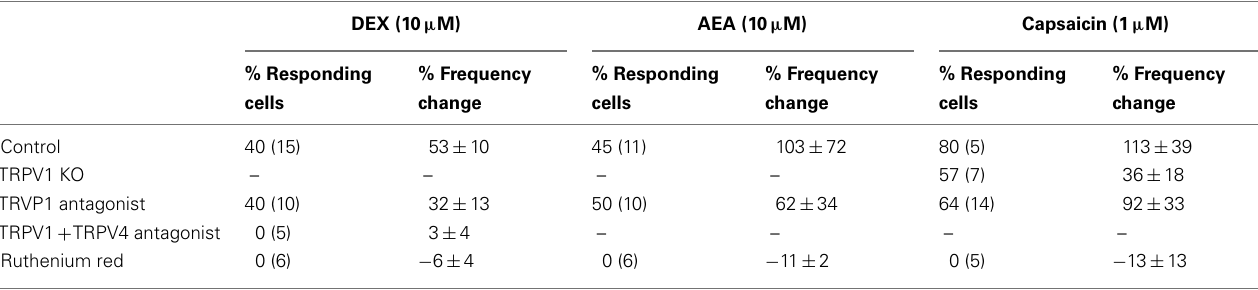
Table 1 | Percent of cells responding with an increase in mEPSC frequency and percent frequency change due to DEX,AEA, and capsaicin after TRPV receptor